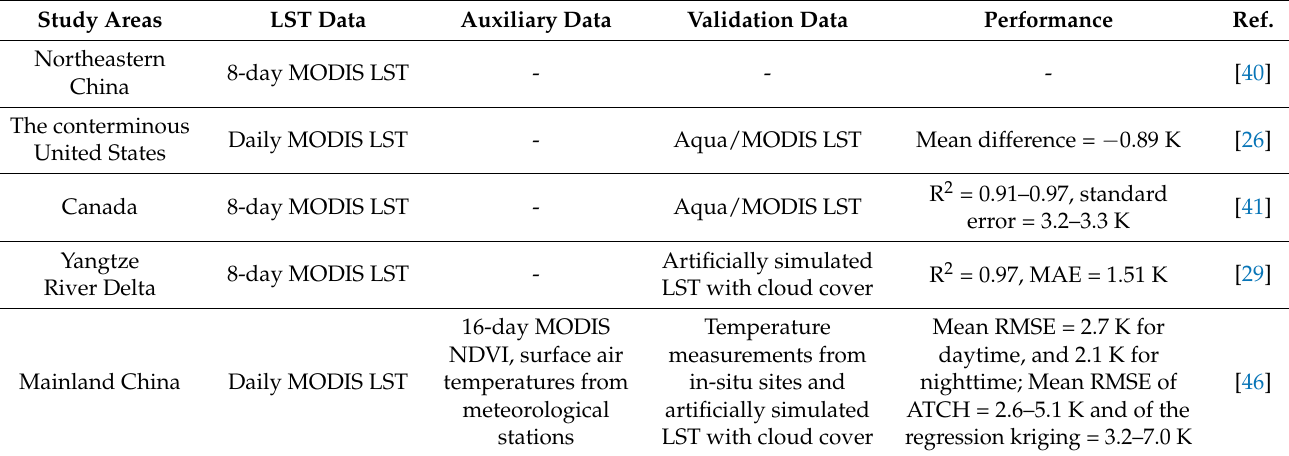
Table 5. Summary of temporal gap-filling